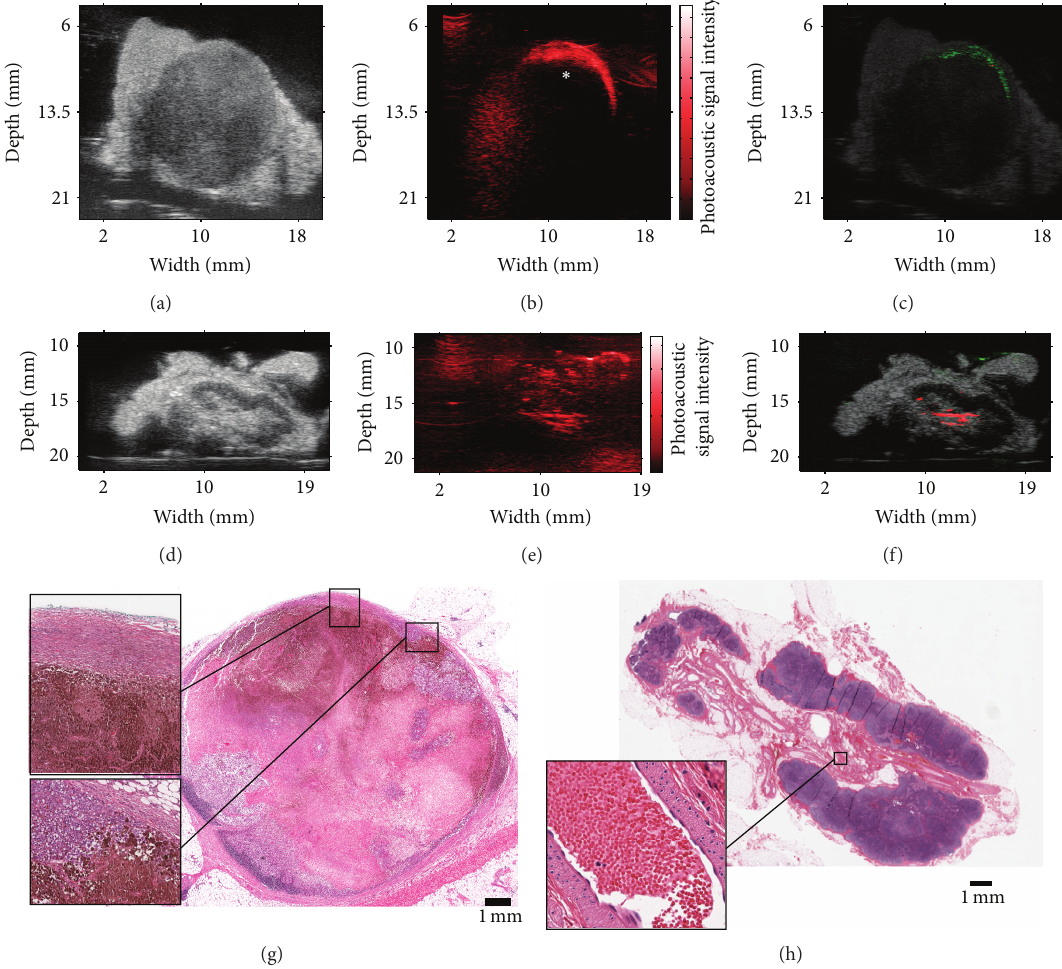
Figure 3: Images of two human nodes. The first row shows images of a metastatic node (node number 2 from Table 1); the second row shows images of a benign node (node number 3 from Table 1). Three columns represent, respectively, high-resolution ultrasound, photoacoustic signal, and the calculated resemblance. The third row shows the pathology slides of the metastatic node (g) and the normal node (h). Absence of photoacoustic signal deeper in the malignant node (as indicated by ∗ in (b)) seems to be caused by the strong absorption by the melanin in the superficial area of the node. The green area in (c) corresponds to the superficial layer of the dark area in (g). The red structure in (f) corresponds to the vessels in the hilum of the benign lymph node